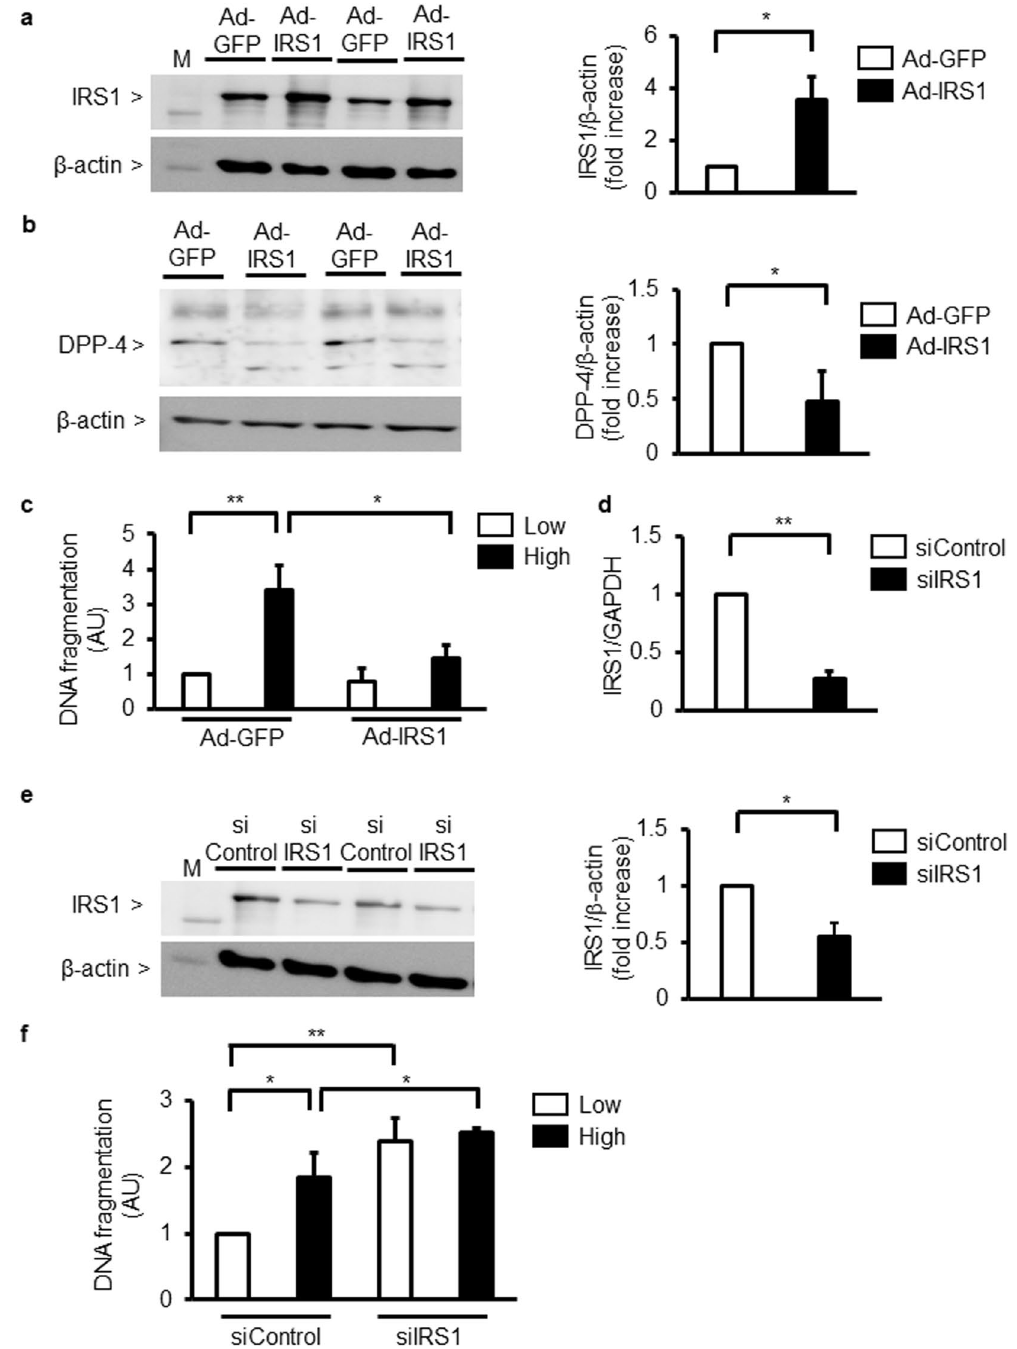
Figure 4. Effect of IRS1 on glucose-induced podocyte apoptosis. ( a ) Immunoblot analysis of IRS1. Podocytes were transfected with adenoviral vectors containing green fluorescent (Ad-GFP or Ad-IRS1) protein. * P < 0.05. ( b ) Immunoblot analysis of DPP-4. Podocytes were transfected with adenoviral vectors containing green fluorescent protein (Ad-GFP or Ad-IRS1). * P < 0.05. ( c ) Podocytes were transfected with adenoviral vectors containing green fluorescent (Ad-GFP or Ad-IRS1) protein and then incubated with low glucose (5.5 mM) or high glucose (25 mM). Podocyte apoptosis was measured by DNA fragmentation. Low; low glucose. High; high glucose. * P < 0.05. ** P < 0.01. ( d ) IRS1 mRNA expression in podocytes. Podocytes were transfected scrambled control siRNA (siControl) or small interfering RNA (siRNA) against IRS1 (siIRS1). ** P < 0.01. ( e ) Immunoblot analysis of IRS1. Podocytes were transfected with scrambled control siRNA (siControl) or small interfering RNA (siRNA) against IRS1 (siIRS1). * P < 0.05. ( f ) Podocytes were transfected with scrambled control siRNA (siControl) or small interfering RNA (siRNA) against IRS1 (siIRS1) and then incubated with low glucose (5.5 mM) or high glucose (25 mM). Podocyte apoptosis was measured by DNA fragmentation. Low; low glucose. High; high glucose. * P < 0.05. ** P < 0.01. These data are expressed as means ± SD. Results are representative of one of three independent